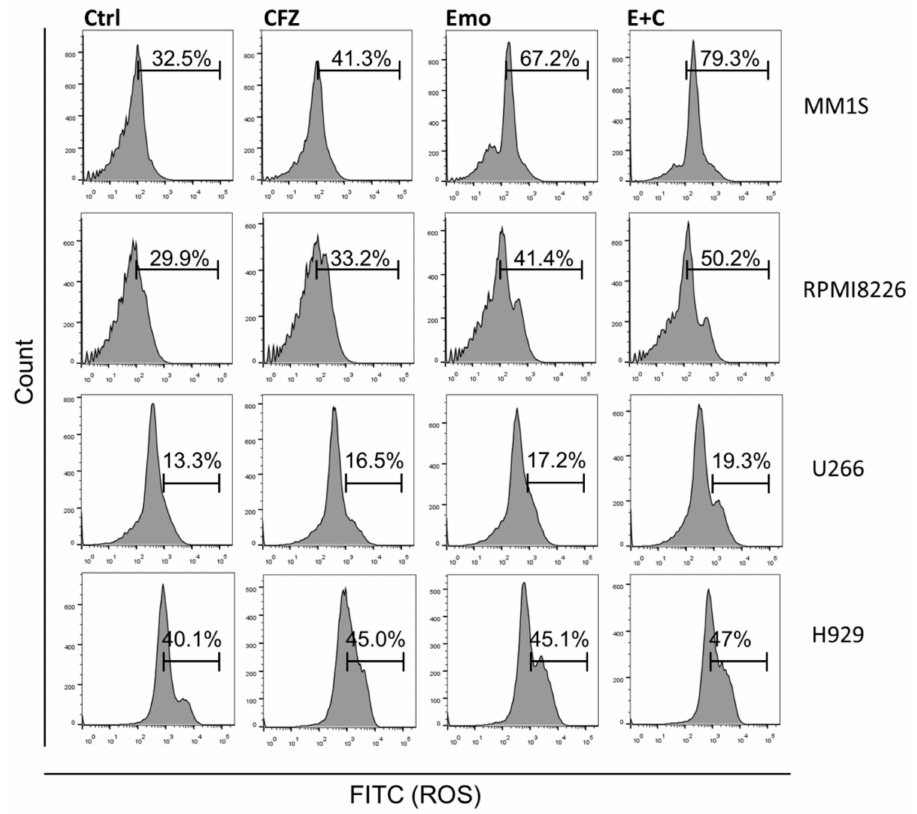
Figure 4. Carfilzomib (CFZ), emodin (Emo), or combination drug of emodin and carfilzomib (E + C) increased ROS production in MM